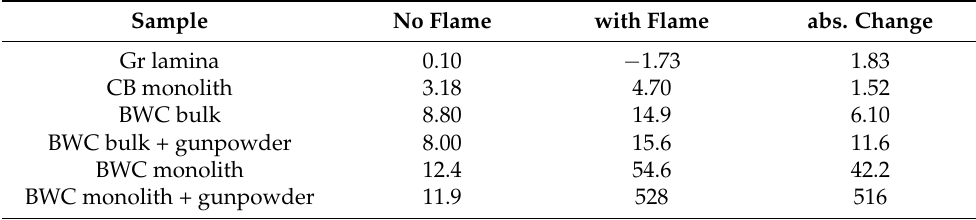
Figure 3. Snapshots of samples subjected to ignition: graphite lamina ( A ); BWC bulk ( B , C ); BWC monolith ( D – F ). In tests ( B – F ) air stream supplied upon ignition. Table 2. Absolute Seebeck coefficients ( µ V/K).